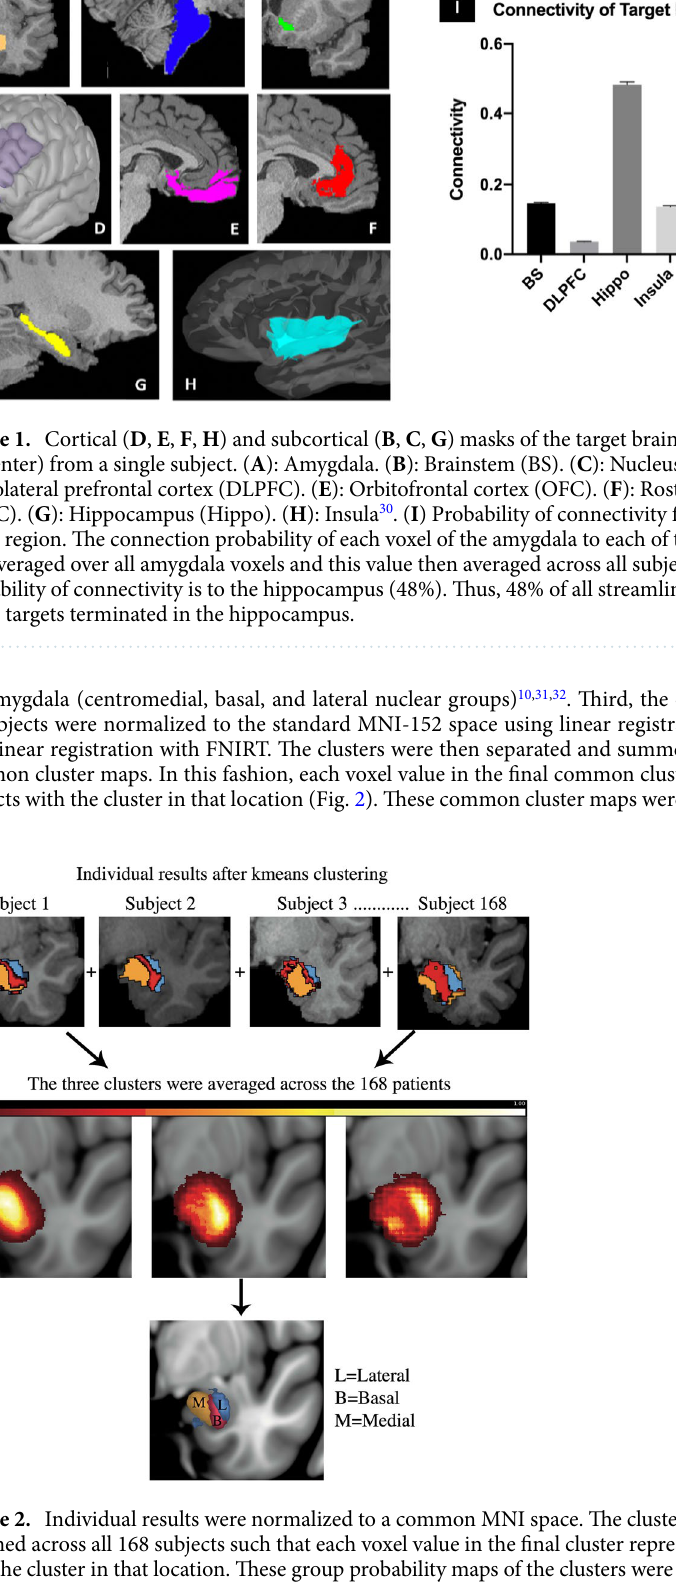
Figure 2. Individual results were normalized to a common MNI space. The clusters were separated and summed across all 168 subjects such that each voxel value in the final cluster represented the number of subjects with the cluster in that location. These group probability maps of the clusters were then thresholded at 50% to optimize the overlap between each